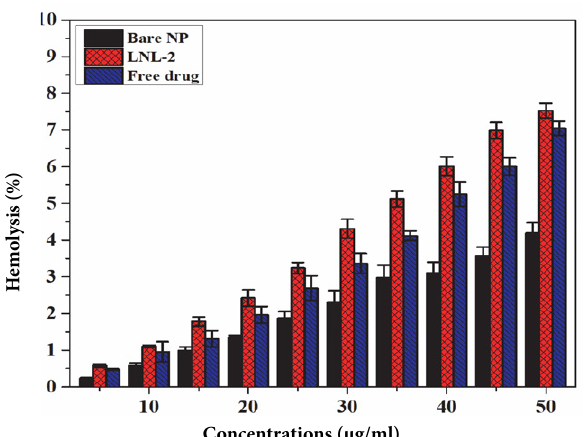
Concentrations (μg/ml)